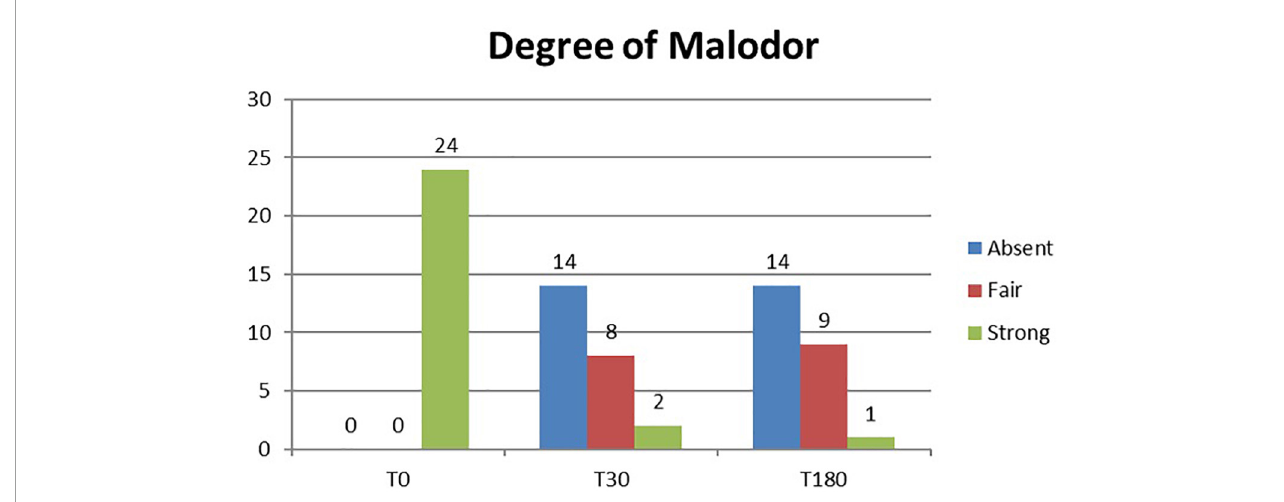
FIGURE1 Histogram representation of the degree of malodor assessment results at baseline (T0) and study follow-up visits (T30 and